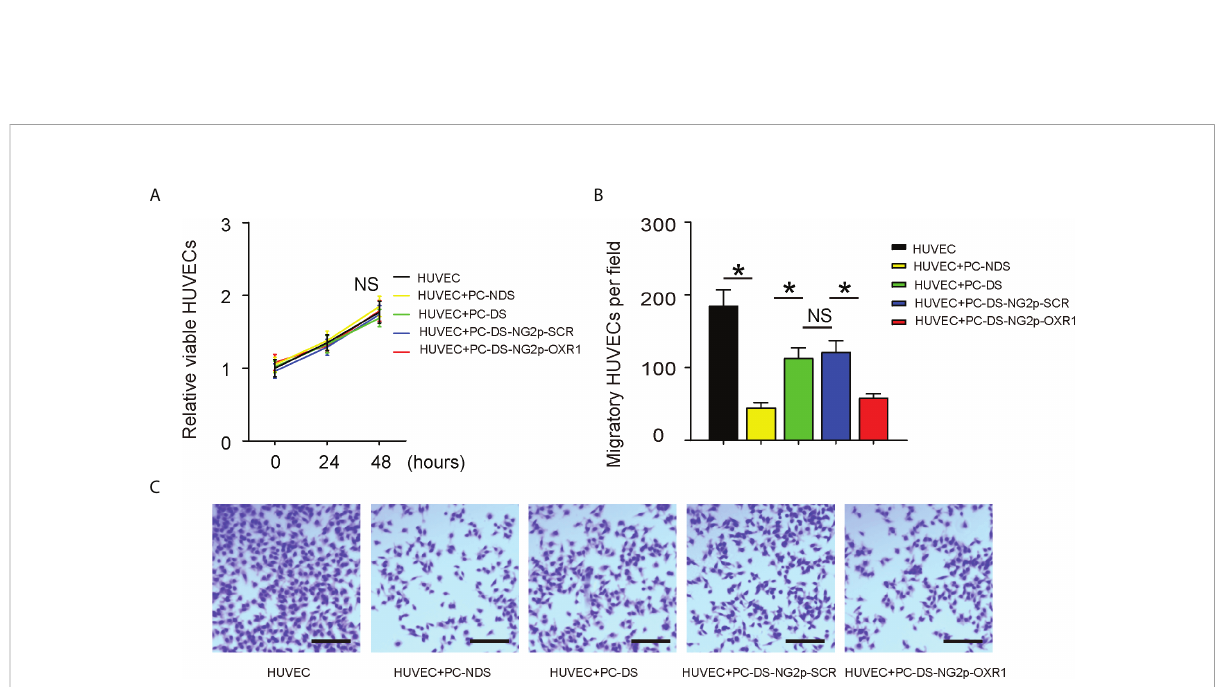
FIGURE 4 OXR1 expression in diabetic pericytes decreases the migratory potential of endothelial cells. The HUVECs were alone or co-cultured with NDS (PC-NDS), uninfected PC-DS, and PC-DS transduced with either AV-NG2p-SCR or AV-NG2p-OXR1. (A) CCK-8 assay. (B, C) A cell migration assay, shown by representative images (B) and by quanti fi cation (C) . * p < 0.05. NS, no signi fi cance. N = 5. Scale bars are 100 µm.